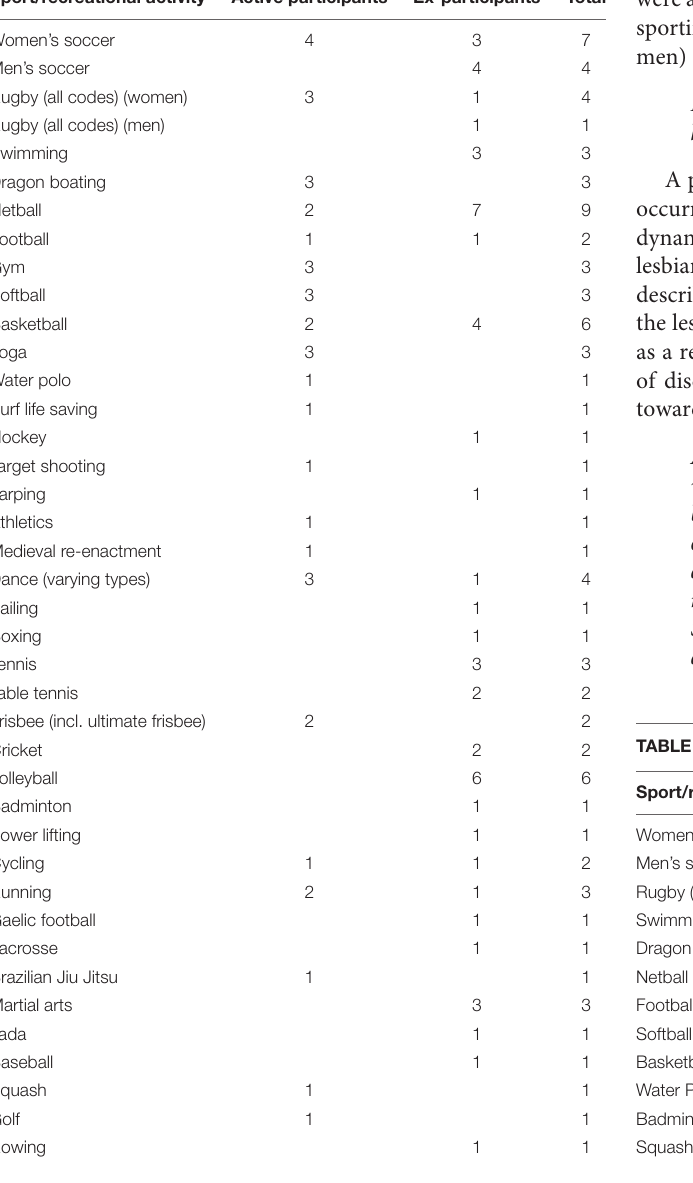
TABLE 4 | Participant representative sports.